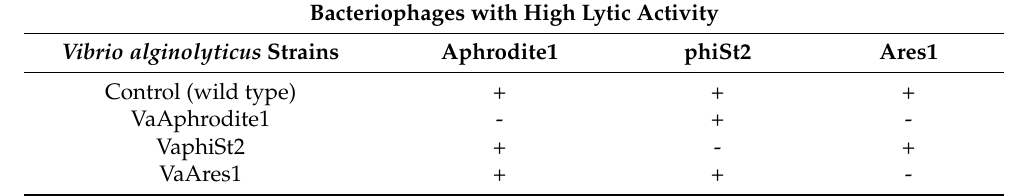
Table 2. Cross-infection test (- for the absence of lytic plaques; + for high lytic activity) of wild-type and resistant strains against highly lytic bacteriophages described in the present study.